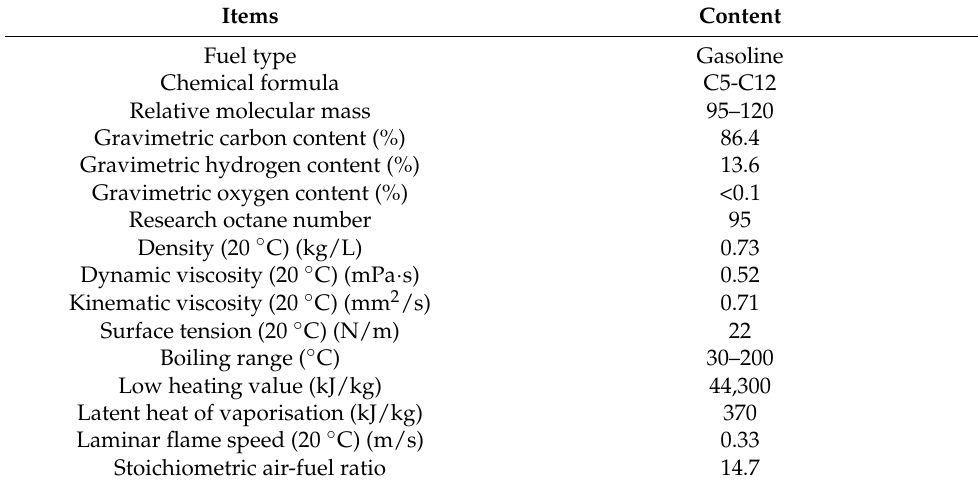
Table 3. Fuel properties.